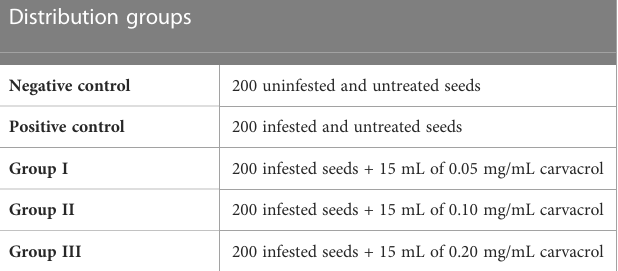
TABLE 2 Distribution groups for the carvacrol treatment under greenhouse. Distribution